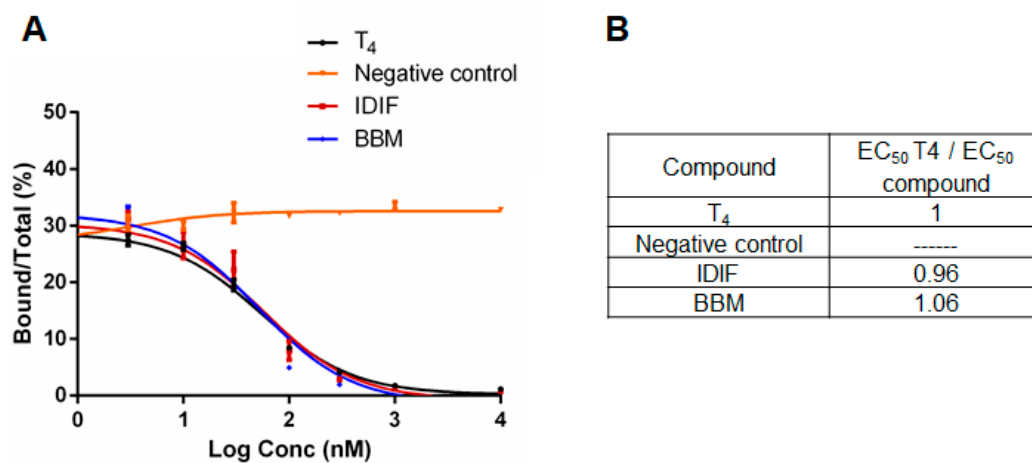
Figure 4. ( A ) Displacement of 125 I-T4 from TTR by competition with the compounds IDIF and BBM, the natural ligand T4 is used as a positive control and sulfaquinoxaline is used as a negative control; ( B ) relative potency for the inhibition of binding of T4.